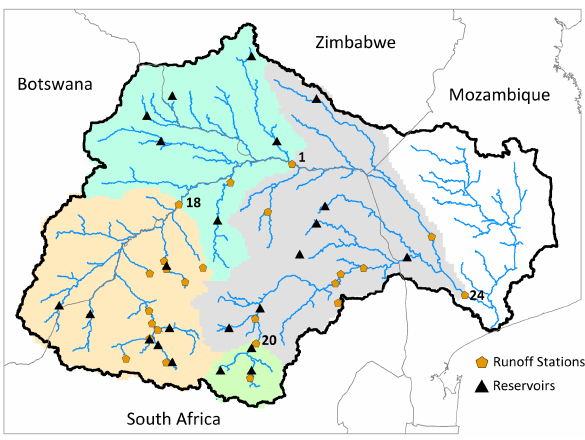
Figure 3. Locations of selected hydrometric stations and reservoirs in the Limpopo